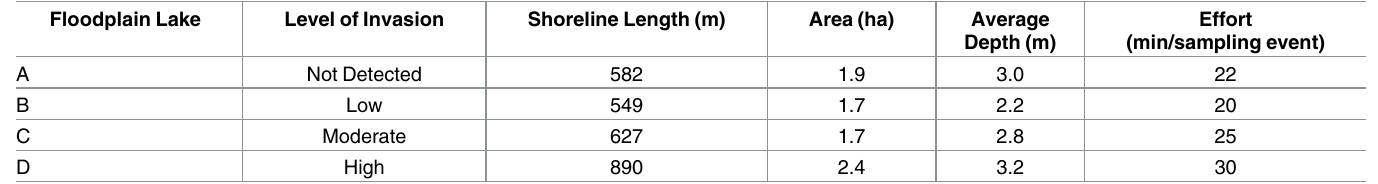
Table 1. Floodplain lake data. Description of the floodplainlakes sampledduringJune and November of 2011 within the New Madrid Floodwayeach with varyinglevels of Silver Carp invasionbased on standardized electrofishing. Floodplain